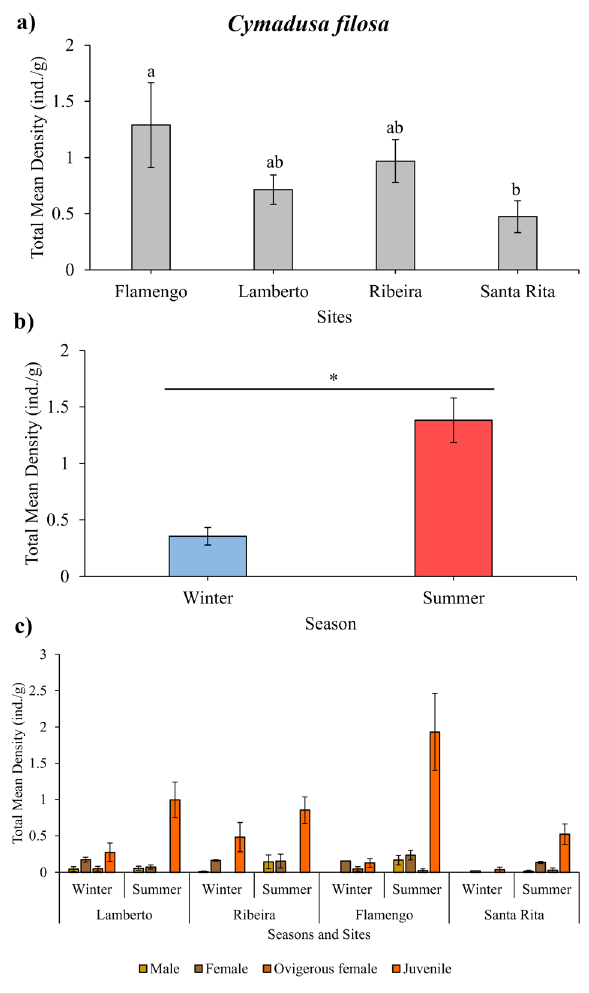
Figure 2. Cymadusa filosa . ( a ) Total mean density (ind./g) of individuals in different sites (± standard error); ( b ) Total mean density (ind./g) between seasons (± standard error); ( c ) Total mean density (ind./g) of males, females, ovigerous females and juveniles at each beach in winter and summer (± standard error). Asterisk represents significant differences and bars with the same letter indicate no significant difference at each